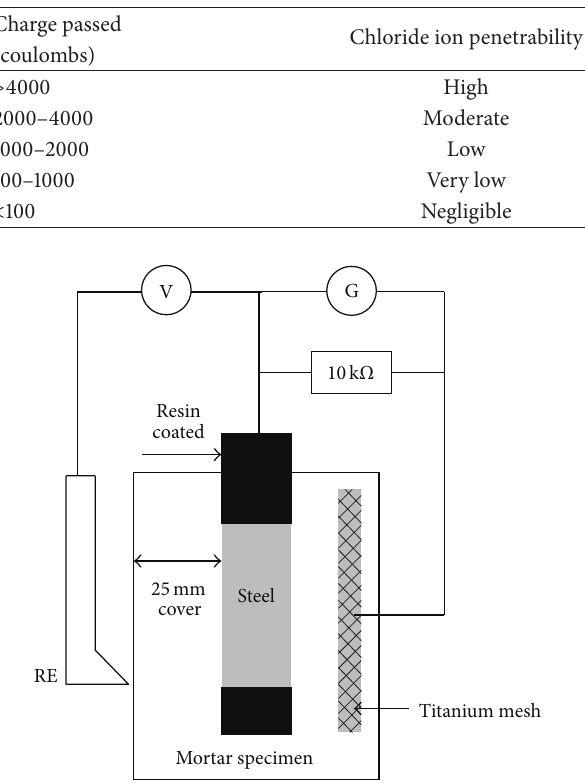
Figure 2: Set-up for galvanic and half-cell monitoring of steel in